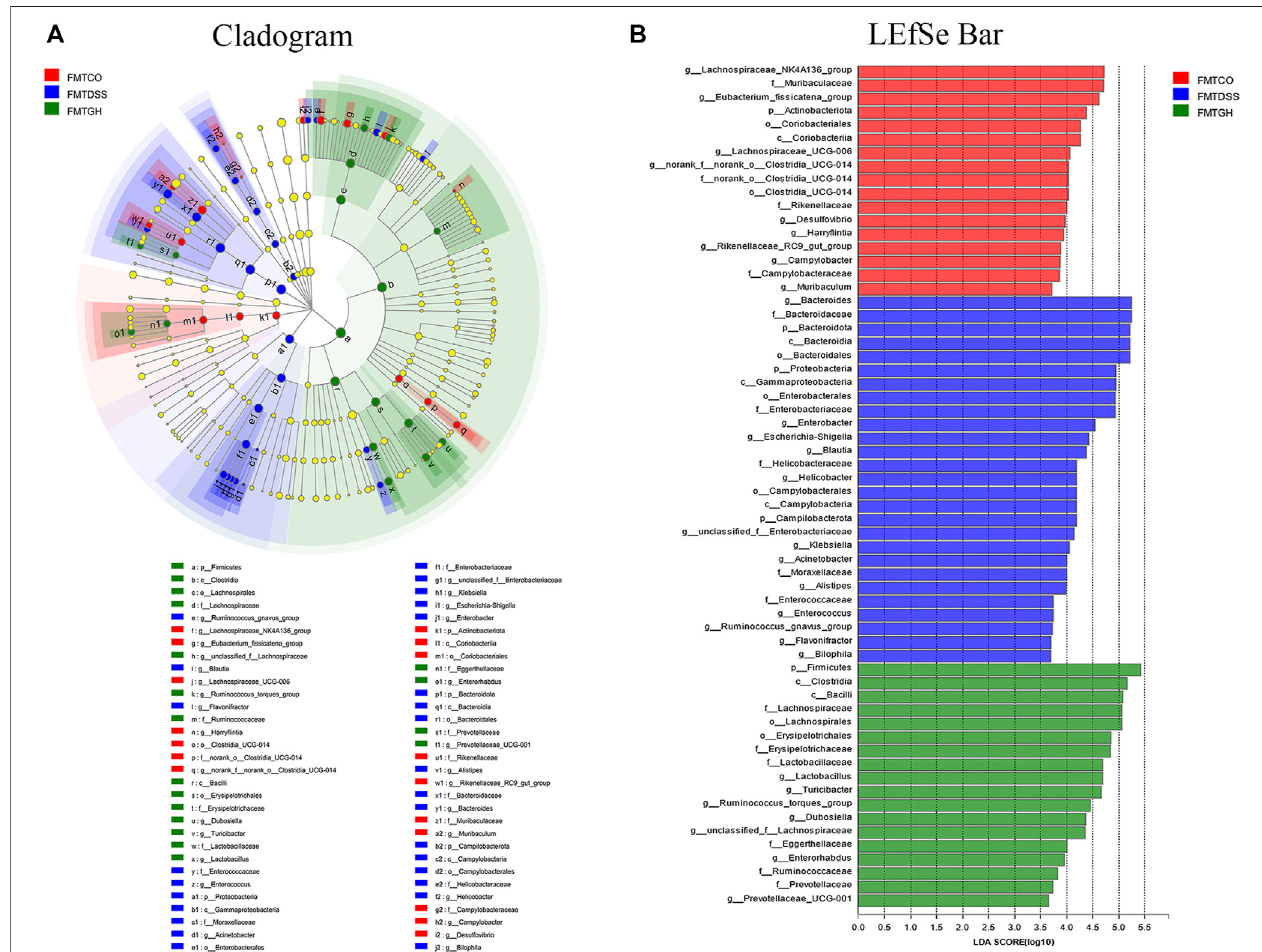
FIGURE 8 | Screening of differentially abundant microbial taxa using linear discriminant analysis (LDA) coupled with effect size (LEfSe) analysis. (A) Cladogram obtained from LEfSe analysis with presenting various levels (from phylum to genus) from inner to outer rings. (B) Biomarker taxons generated from LEfSe analysis. The criteria for feature selection is log LDA score >